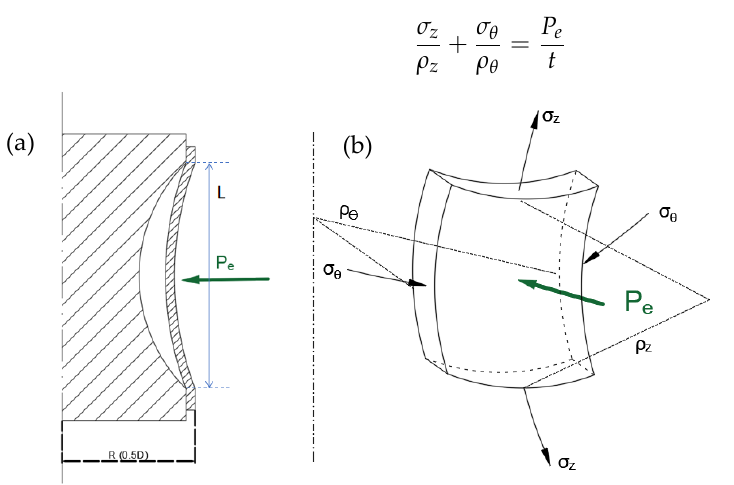
Figure 3. ( a ) Schematic view of compressive deformation under an external pressure and ( b ) stress state of an element of the tube at the compressive region.